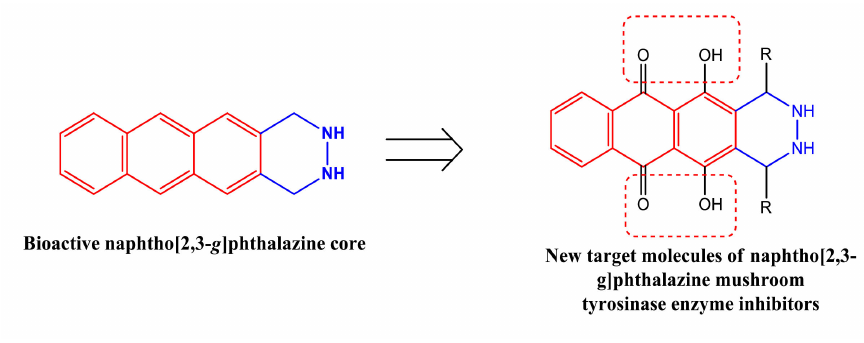
Figure 1. Target molecules of tyrosinase enzyme